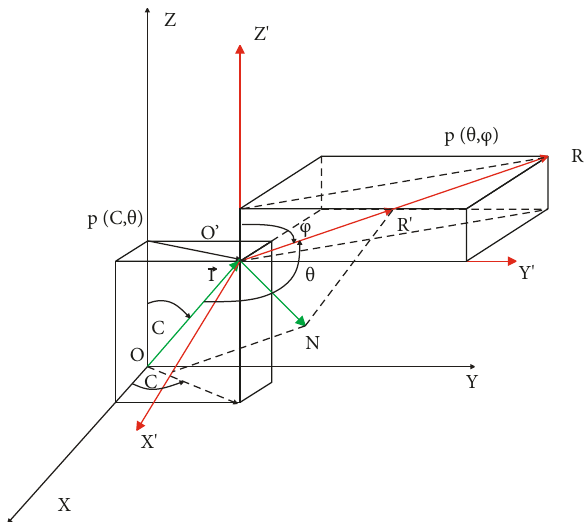
Figure 1: Light refraction path in a dual coordinate